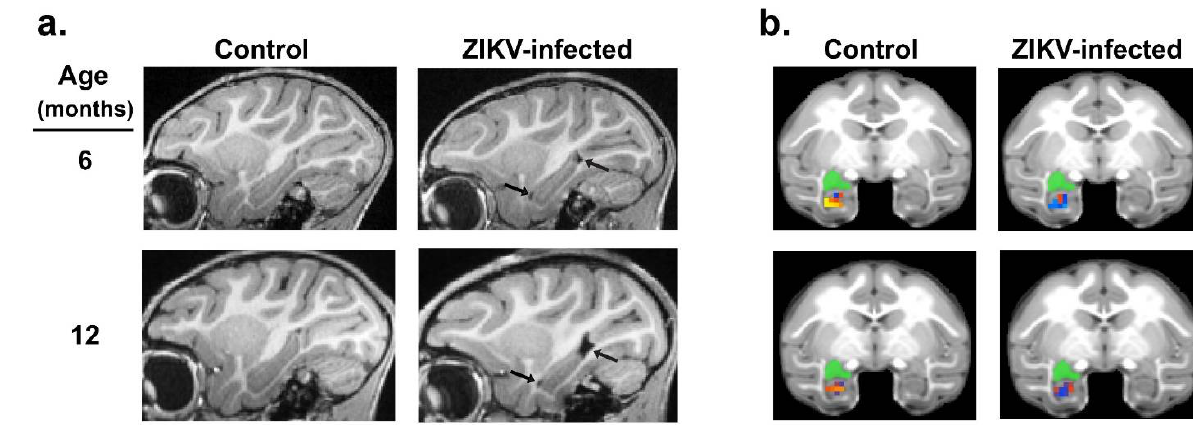
Figure 2. Consequences of postnatal ZIKV infection on neurodevelopment. Magnetic resonance imaging (MRI) in infant macaques illustrates the impact of early ZIKV exposure on hippocampal growth ( a ) (black arrows point to increased lateral ventricle volume, also indicating decreased hippocampal volume) and resting-state functional connectivity ( b ) between the left amygdala (green seed) and hippocampus at 6 and 12 months of age. Reproduced with modifications from Mavigner, et al. (2018) [72] and Raper et al. (2020) [73].